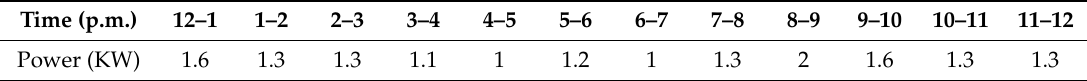
Table 2. Typical load profile for critical household